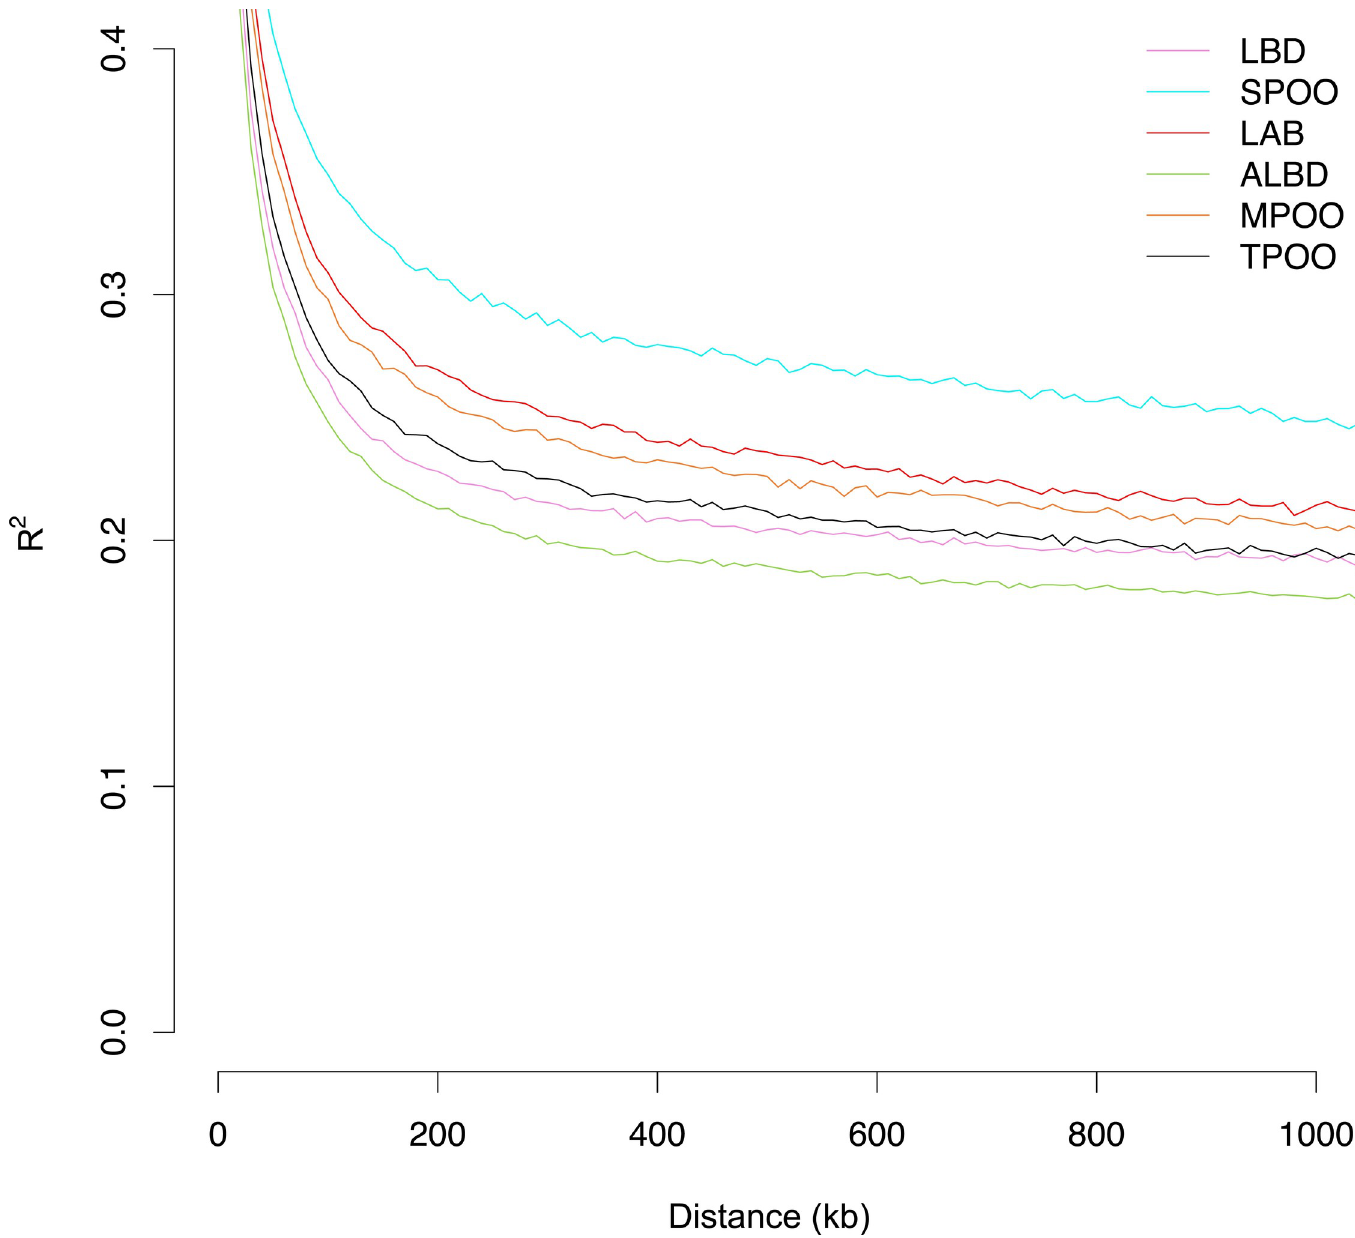
Fig 7. LD decay curve of LBD and ALBD and component breeds. Multigenerational ALBD and LBD decay plots using six dogs per breed are shown in comparison to parent breeds. Data are based on a mean r 2 using a window size of one Mb.